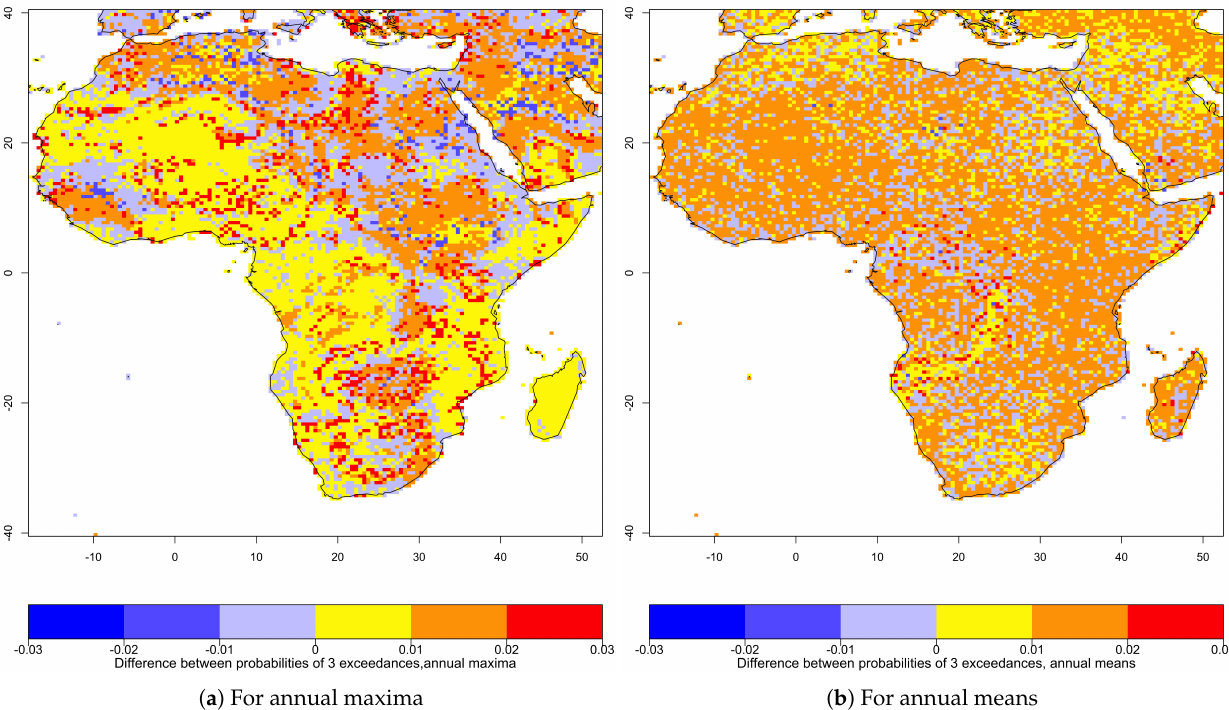
Figure 12. Difference between probability of 3 exceedances over two different 19 years periods (2020 to 2038, and 2001 to 2019). P ( 3 exceedances over the second 19 years ) P ( 3 exceedances over the first 19 years ) for: ( a ) annual maximum − temperatures and ( b ) annual mean